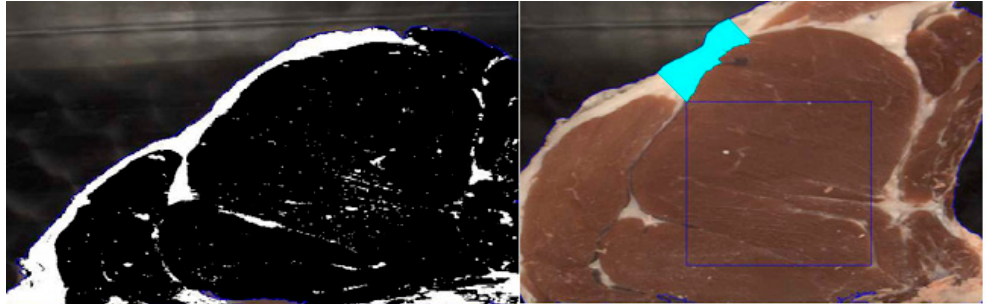
Figure 1. Visualisation of the segmentation of meat and fat pixels ( left ) and the standardized position for the assessment of the rib-eye fat thickness at the 10th/11th rib position ( right ).